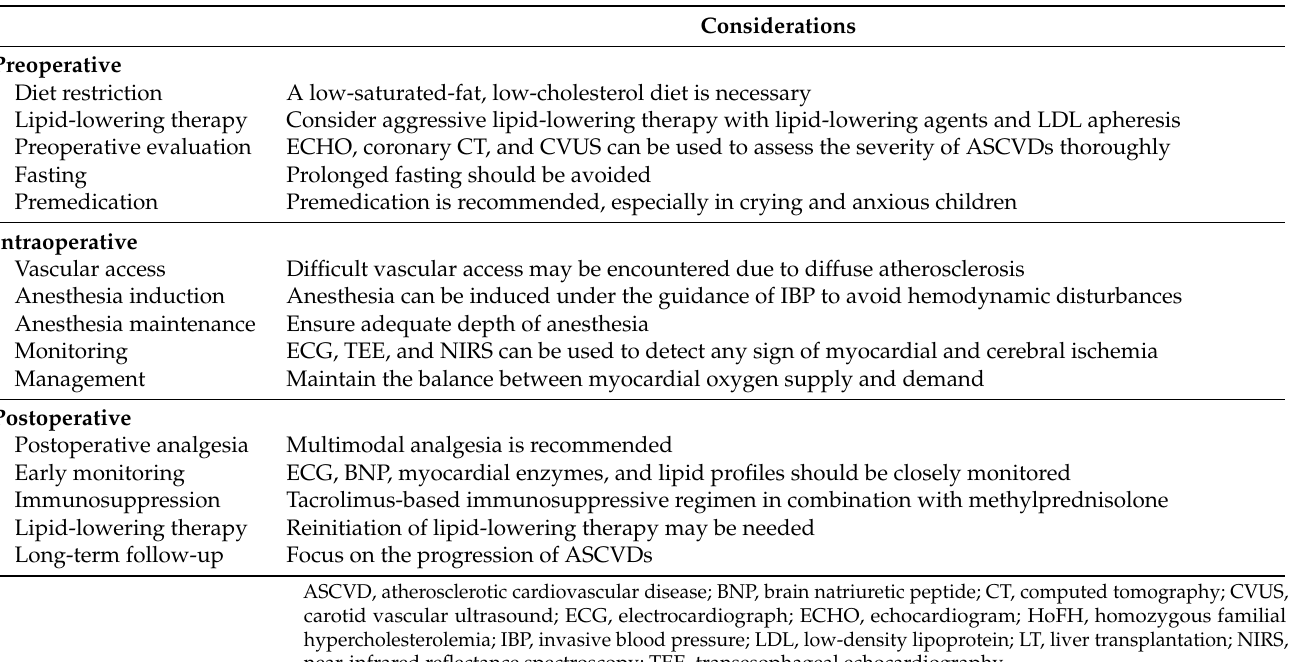
Table 3. Summary of perioperative considerations of LT for HoFH